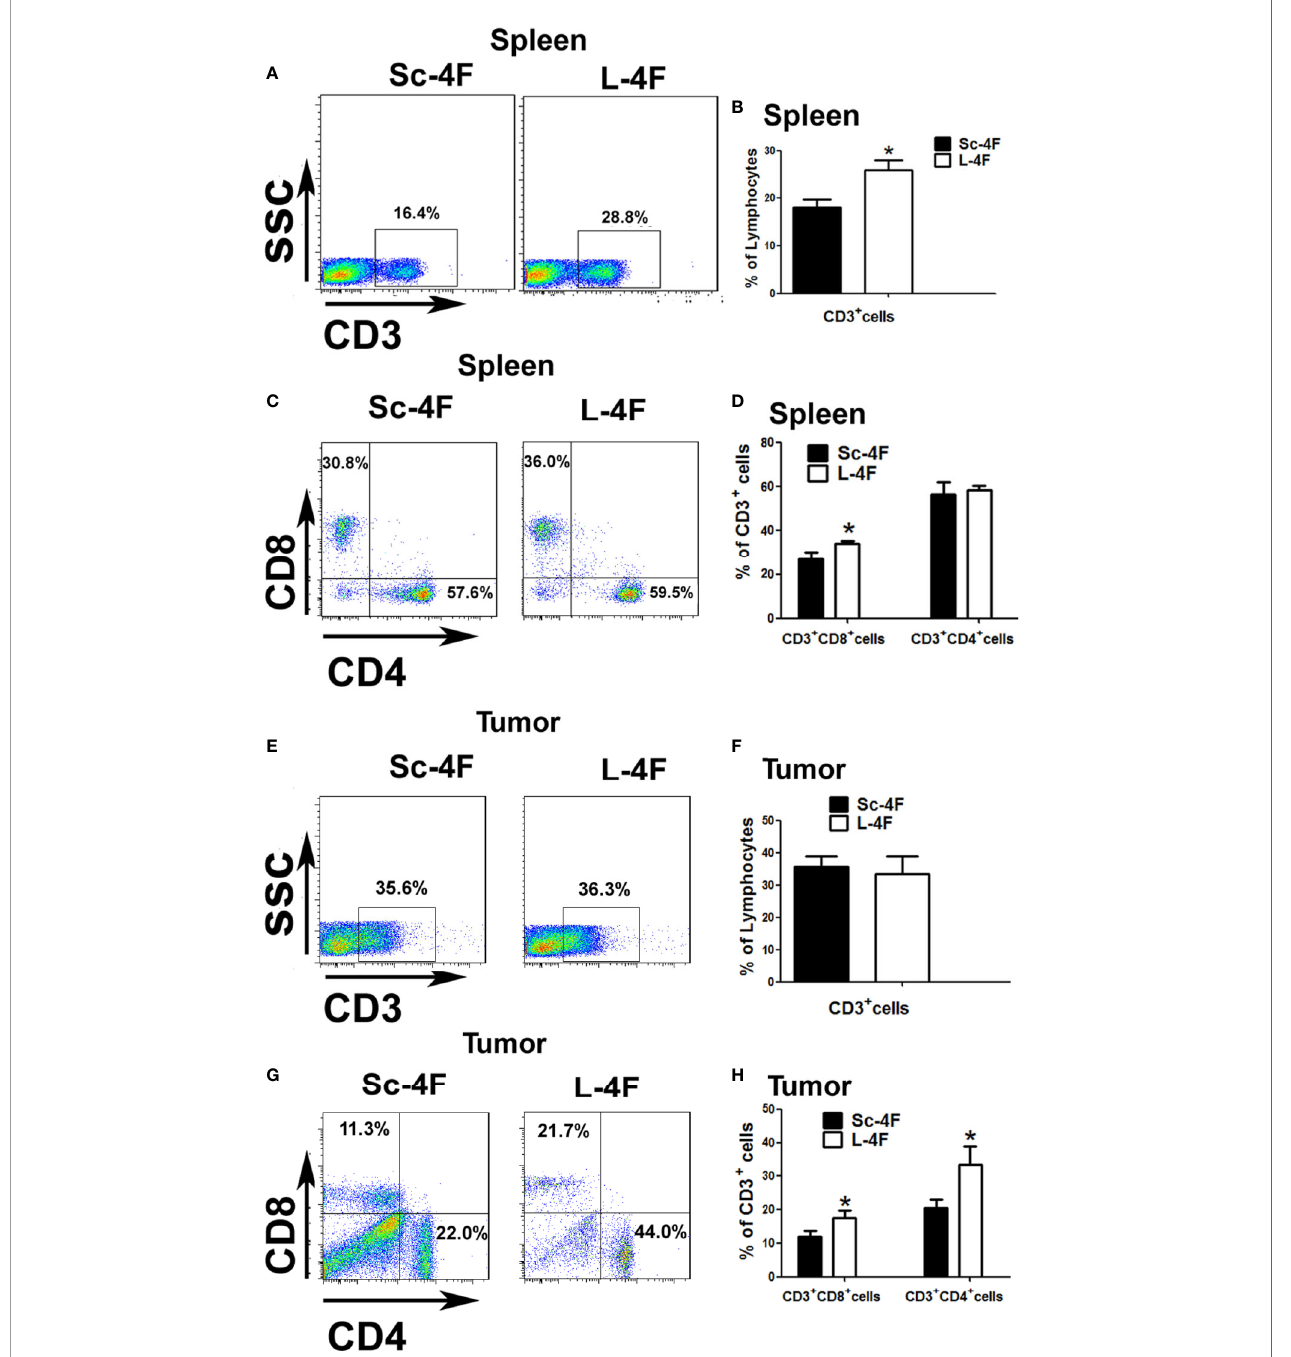
FIGURE 3 | The percentages of in fi ltrated T cells in the spleen or tumor tissue of mice with pancreatic cancer. The spleen and tumor were collected from the Sc-4F/ L-4F-treated mice. Single-cell suspensions were generated, and the cells were immunostained for CD3, CD4, and CD8. (A, C, E, G) One representative result from each experiment. The percentage of CD3 + cells among the splenocytes (B) and tumor-in fi ltrating cells (F) (*P < 0.05). The percentage of CD3 + CD8 + T cells and CD3 + CD4 + T cells among the CD3 + T population of the splenocytes (D) and tumor-in fi ltrating cells (H) (*P <